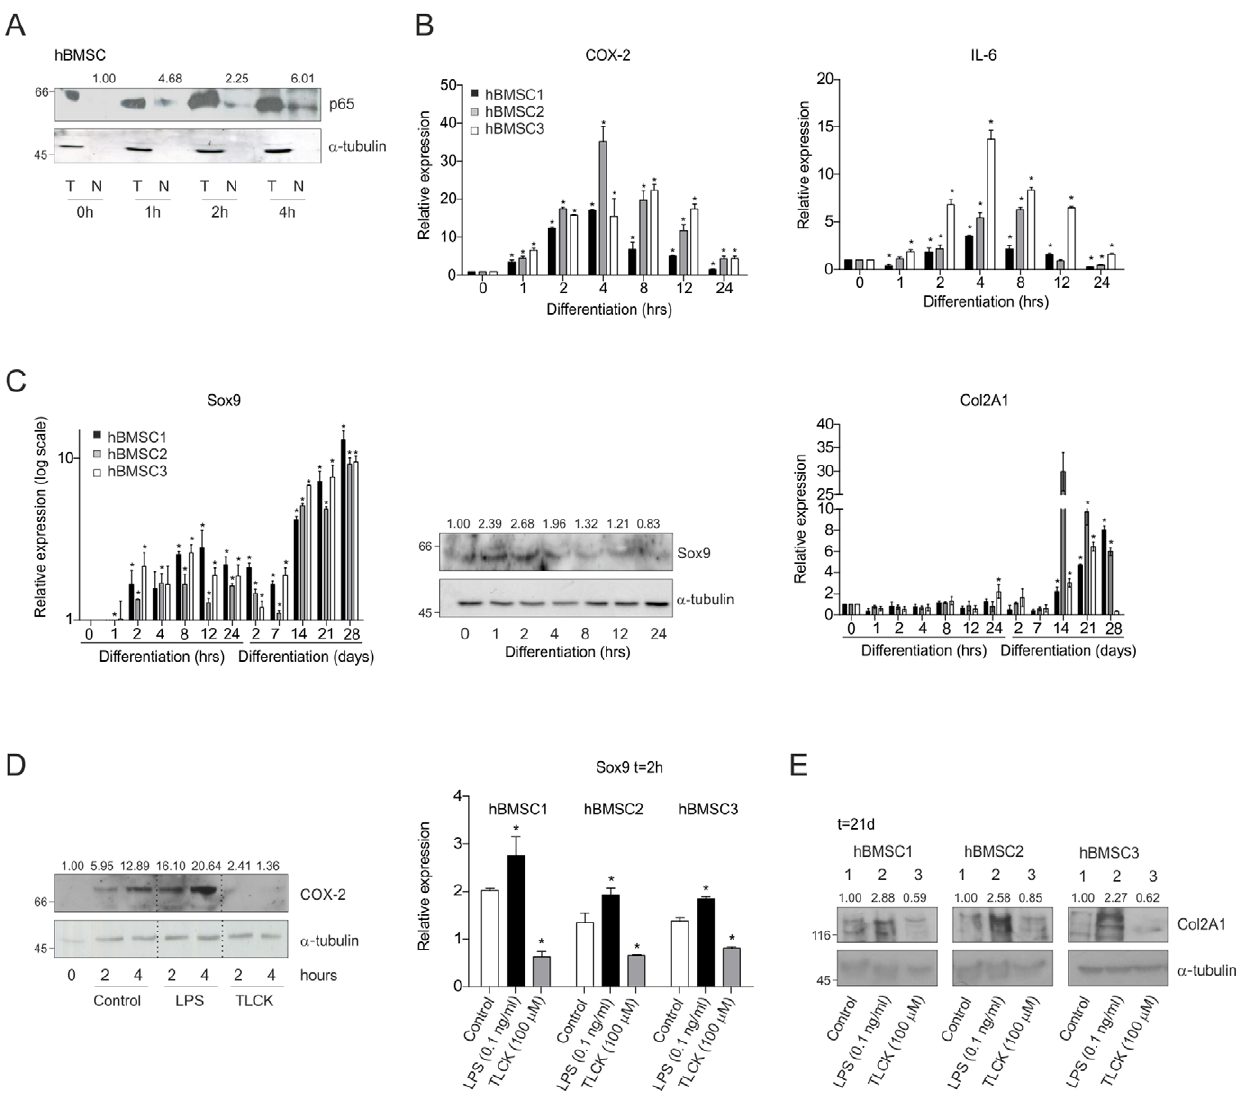
Figure 4. Transient NF- k B/p65 signaling during early chondrogenic differentiation of human bone marrow stem cells. Human bone marrow stem cells from three individuals (hBMSC1/2/3) were differentiated into the chondrocyte lineage using monolayer culture. A: Nuclear (N) and total (T) fractions were isolated from 0, 1, 2, 4 hours samples. NF- k B was detected as p65, cytoplasmic marker: a -tubulin. B: Expression of COX-2 and IL-6 mRNAs at 0–24 hours in hBMSC differentiation. C: Left; Sox9 mRNA expression during hBMSC differentiation, Sox9 protein expression during 0– 24 hours in hBMSC differentiation (middle) and Col2A1 mRNA expression during hBMSC differentiation (right). D: Left; COX-2 protein expression at 0, 2, 4 hours in differentiation in the presence of LPS (0.1 ng/ml) or TLCK (100 m M). Right; Sox9 mRNA expression at 4 hours in differentiation in the presence of LPS (black bars) or TLCK (grey bars). E: Col2A1 protein expression in day 21-samples of differentiated hBMSCs. Lanes 1: control condition, Lanes 2: 0.1 ng/ml LPS (only first 24 hours) and lanes 3: 100 m M TLCK. *=p , 0.05.